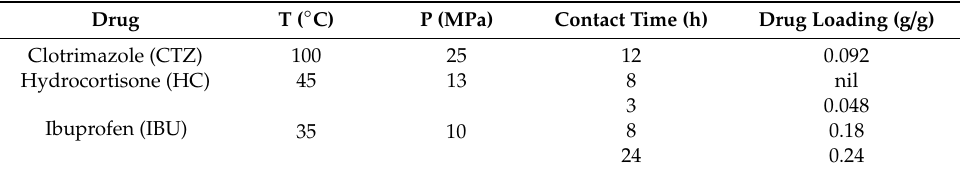
Table 4. Drug loading of the di ff erent mesoNsZnO drug systems.